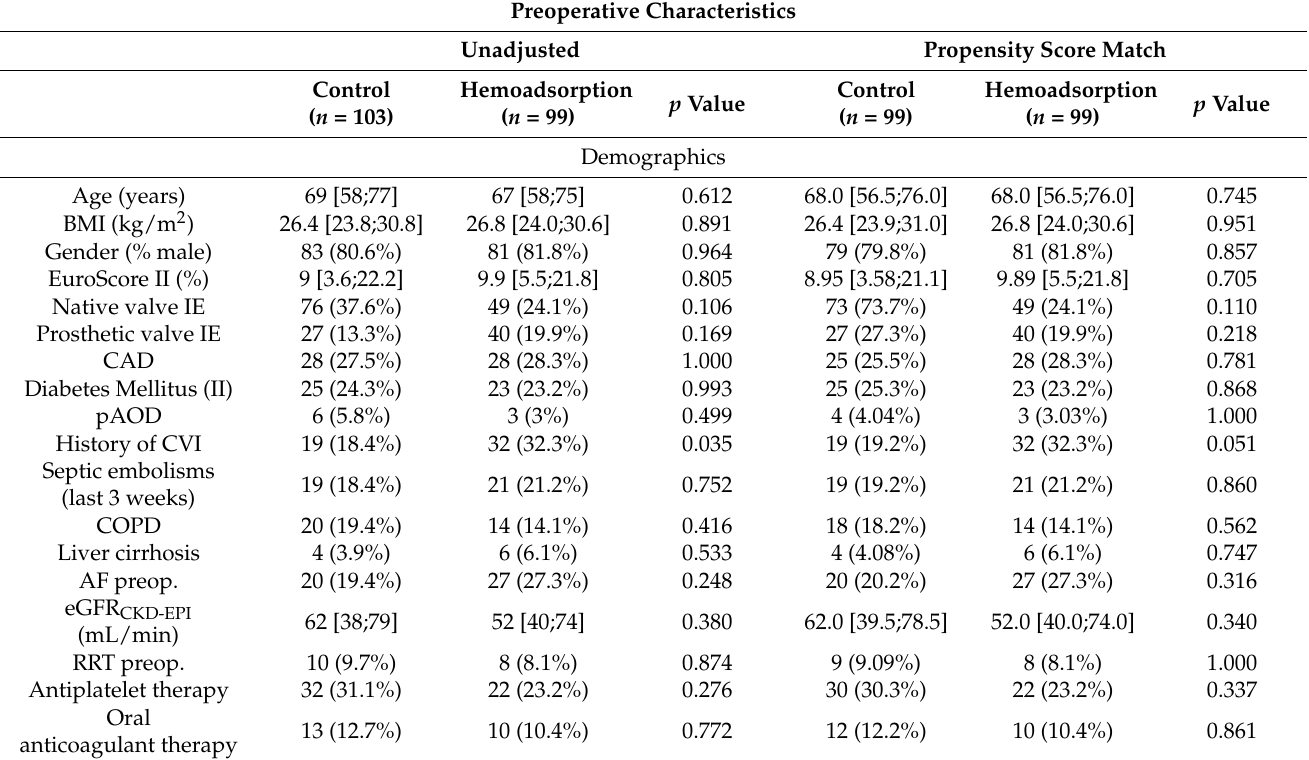
Table 1. Preoperative patient